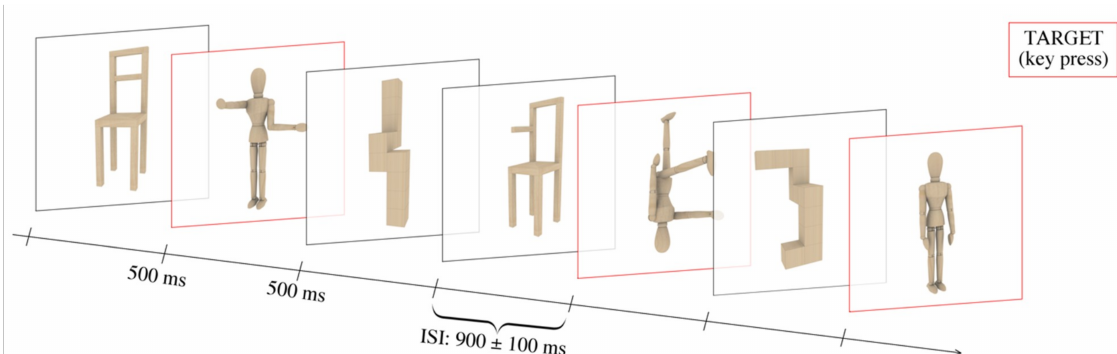
Figure 2. Timescale of the experimental design. The stimuli were presented for 500 ms at the center of the screen, separated by an ISI (inter-stimulus interval) of 900 ± 100 ms. The participants were instructed to recognize a specific target category (i.e., bodies, as illustrated by the red squares in the present figure), indicated at the beginning of each run, by button